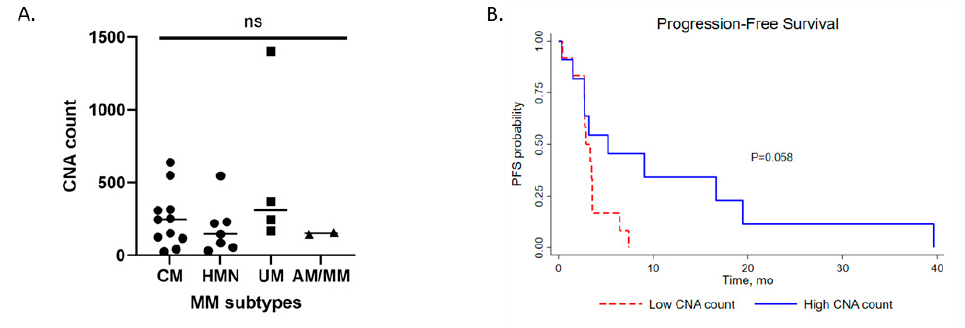
Figure 4. ( A ). Profile of CNA count on subtypes of metastatic melanoma (CM ; HNM ). ( B ). Progression-free survival (PFS) of CNA low (red line) and high (blue line) in the total metastatic melanoma cohort. Kaplan–Meier survival curves with a log-rank test were used for the analysis. ns, not